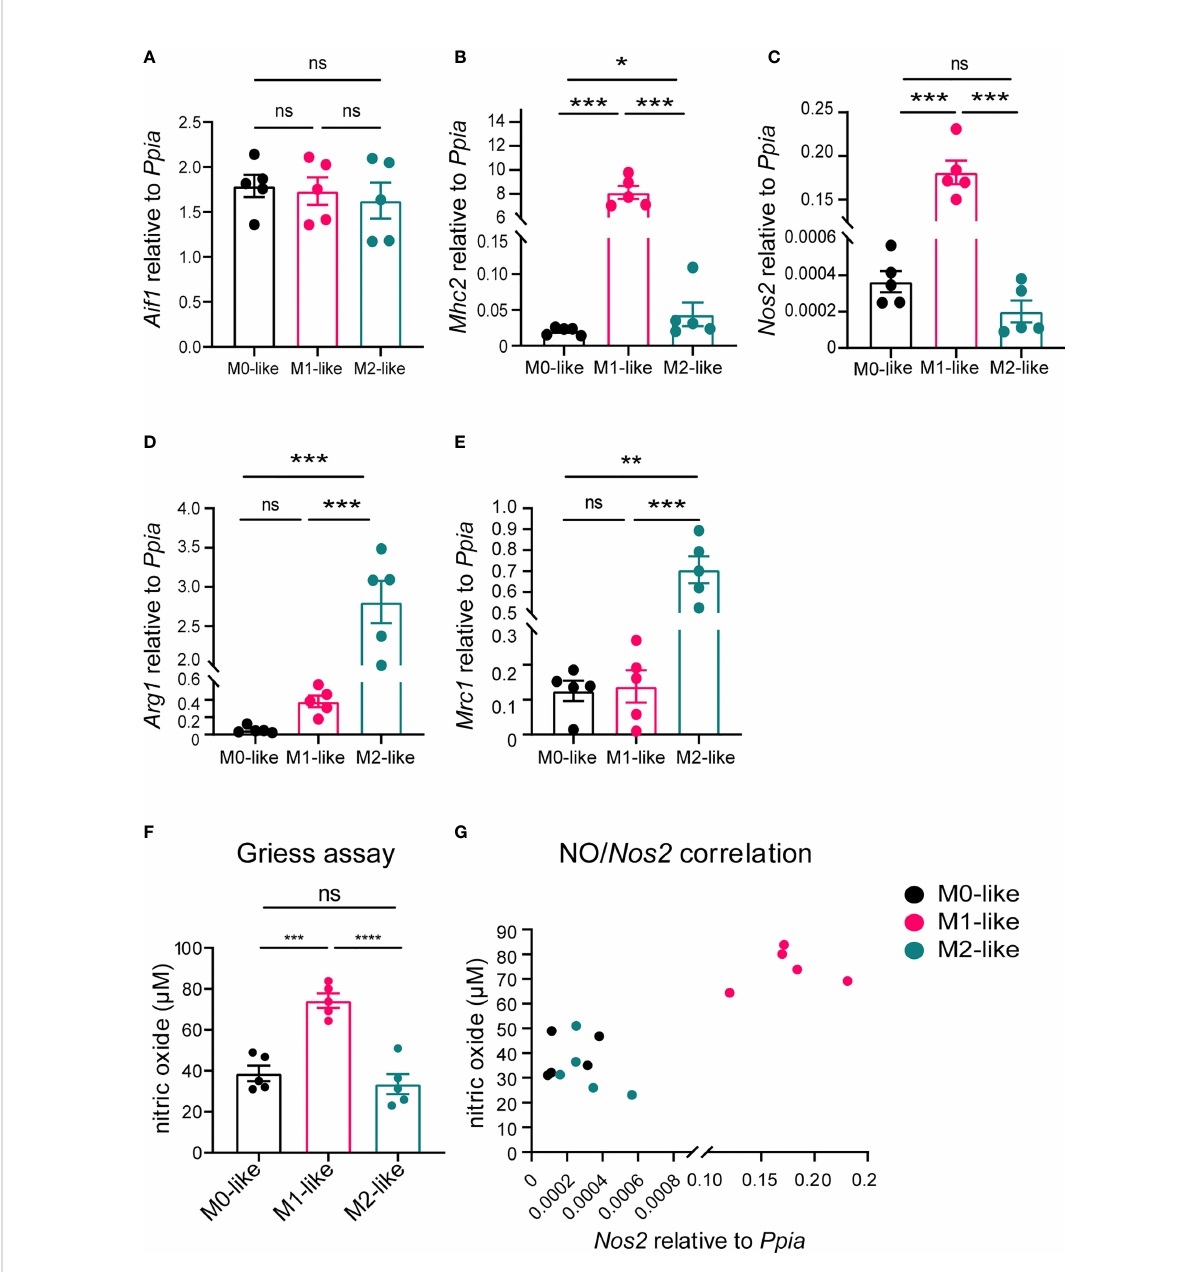
FIGURE 2 Microglia subtypes differ in M1/M2 gene marker expression and metabolism. (A – E) Gene expression analyses of the pan-marker Aif1 , M1- markers Mhc2 , Nos2 and M2 markers Arg1 , and Mrc1 demonstrating differential expression by microglia subtypes. Ppia was used as a reference gene. (F) Alterations in cellular arginine metabolism were detected by colorimetric Griess assay, with M1-like microglia releasing signi fi cantly more NO than M0- or M2-like microglia. (G) Scatter plot showing positive correlation between NO and Nos2 expression (non-parametric Spearman correlation, r = 0.8842, p < 0.0001). Values are expressed are mean ± SEM from 5 individual experiments (biological replicates), one- way ANOVA ( post-hoc correction Holm-S ̌ ı ́ da ́ k), *p < 0.05, **p < 0.01, ***p < 0.001, ****p < 0.0001. ns, not signi fi